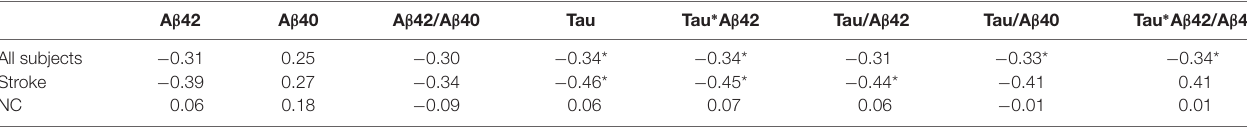
TABLE 2 | Partial correlations of mean cortical thickness with plasma A β 40, A β 42, and tau protein and their composite scores after adjustment for